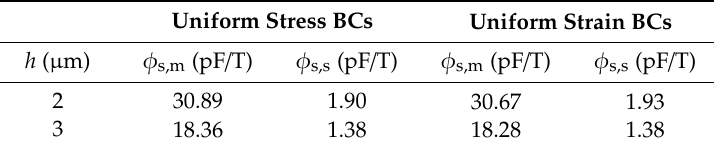
Table 4. Monte Carlo simulation: e ff ect of the target in-plane film width h and of the type of BCs on the values of mean φ s,m and standard deviation φ s,s of the scattered device